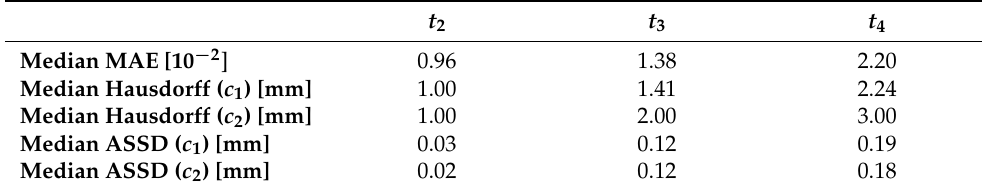
Table 3. Median values of the voxelwise mean absolute error (MAE) between the true and estimated cell-density distributions within the c > 0.01 contour as well as of the Hausdorff distance and average symmetric surface distance (ASSD) between the true and estimated imaging contours for threshold values of c 1 = 0.80 and c 2 = 0.16 computed over the test set for times t 2 , t 3 , and t 4 . t 2 t 3 t 4 Median MAE [10 − 2 ] 0.96 1.38 2.20 Median Hausdorff ( c 1 ) [mm] 1.00 1.41 2.24 Median Hausdorff ( c 2 ) [mm] 1.00 2.00 3.00 Median ASSD ( c 1 ) [mm] 0.03 0.12 0.19 Median ASSD ( c 2 ) [mm] 0.02 0.12 0.18 The distributions of the relative error on the values of λ and v computed at time t 2 over the test set as well as on the values of d white and ρ derived with Equations (12) and (13) are summarized by boxplots in Figure 10. The corresponding median relative errors were 3.41%, 3.30%, 5.86%, and 2.75% for λ , v , d white , and ρ , respectively. The true versus predicted values of λ and v as well as of d white and ρ from the test set are plotted in Figure 11. The corresponding Lin’s concordance correlation coefficients (CCC) [47] were 0.99, 0.95, 0.97, and 0.99 for λ , v , d white , and ρ , respectively.